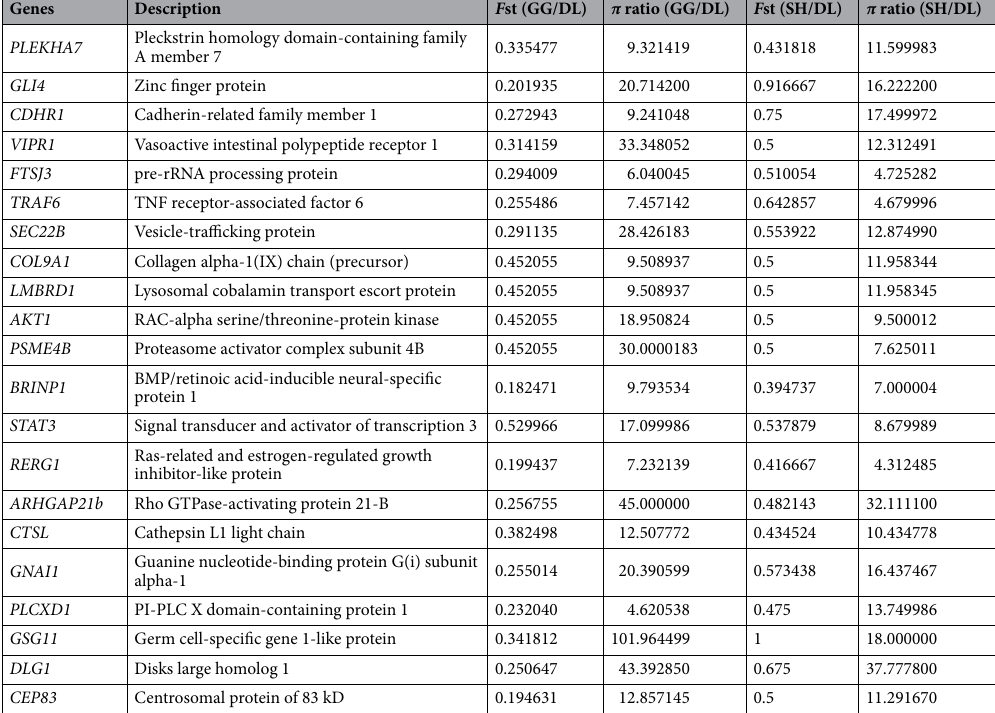
Table 2. Genes located in selective loci shared by two pairwise groups (GG/DL and